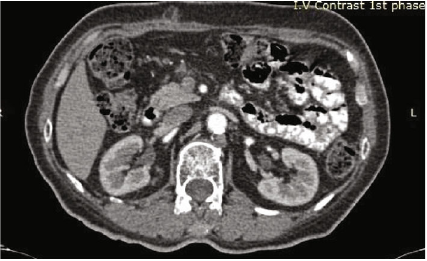
Figure 2: Follow-up computed tomography (CT image) with no evidence of recurrent